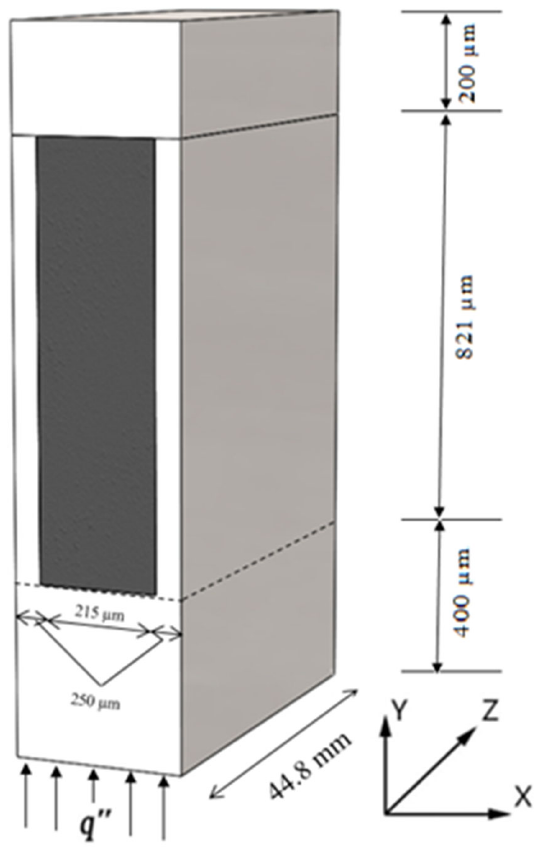
Figure 1. Dimensional demonstration of the microchannel.